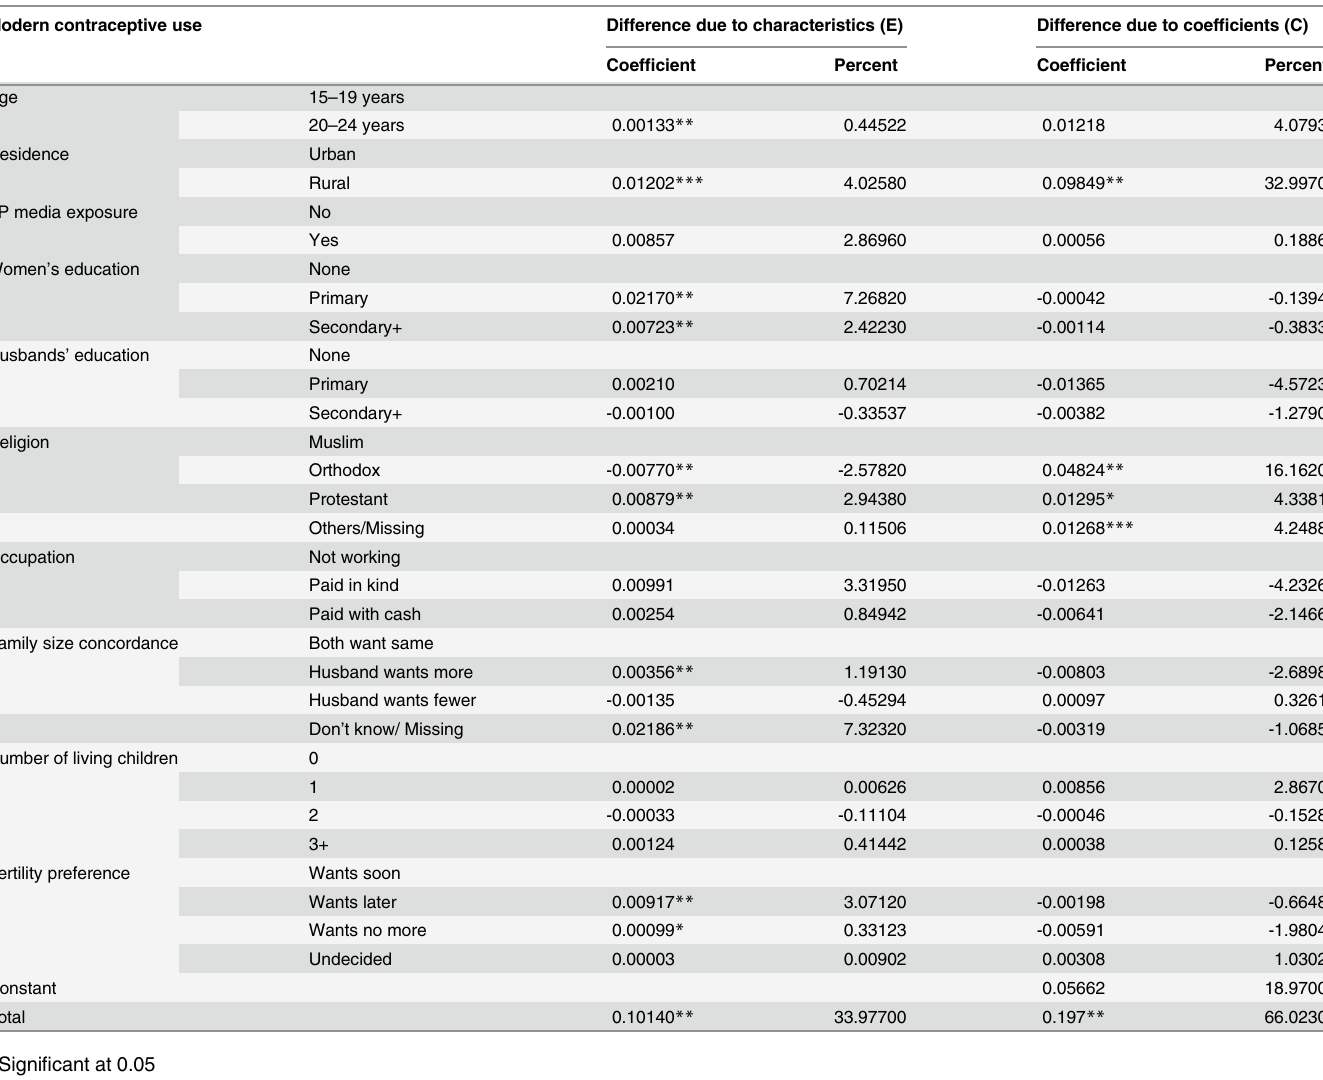
Table 4. Decomposition of change in modern contraceptive use among young married women in Ethiopia, 2000 to